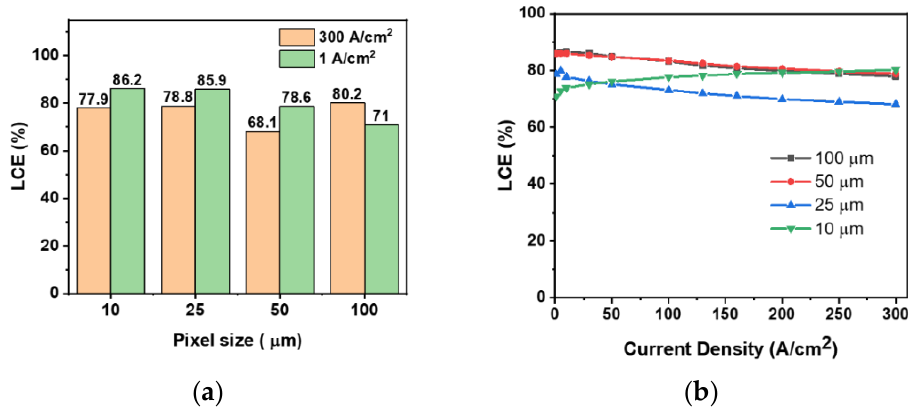
Figure 11. Color conversion efficiency of red QD micro-LEDs with different sizes: ( a ) LCE at injected current density of 300 A/cm 2 and 1 A/cm 2 . ( b ) LCE as a function of current density.